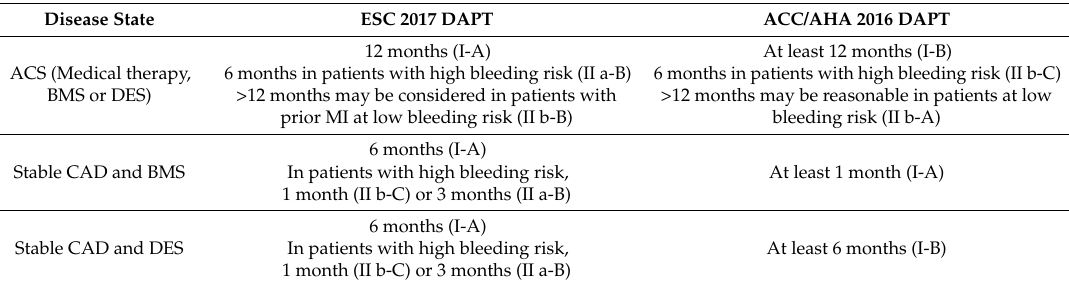
Table 6. Guideline statements on DAPT